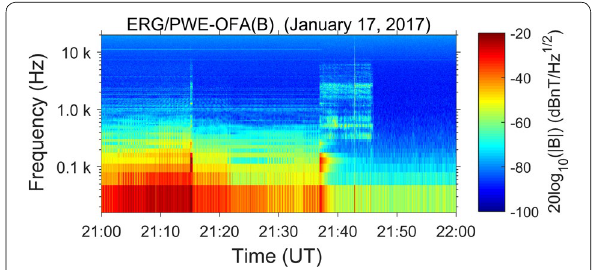
Fig. 15 Frequency–time diagram of | B | during the extension opera- tion for the MAST on January 17, 2017 ( 0dBnT/Hz 1 / 2